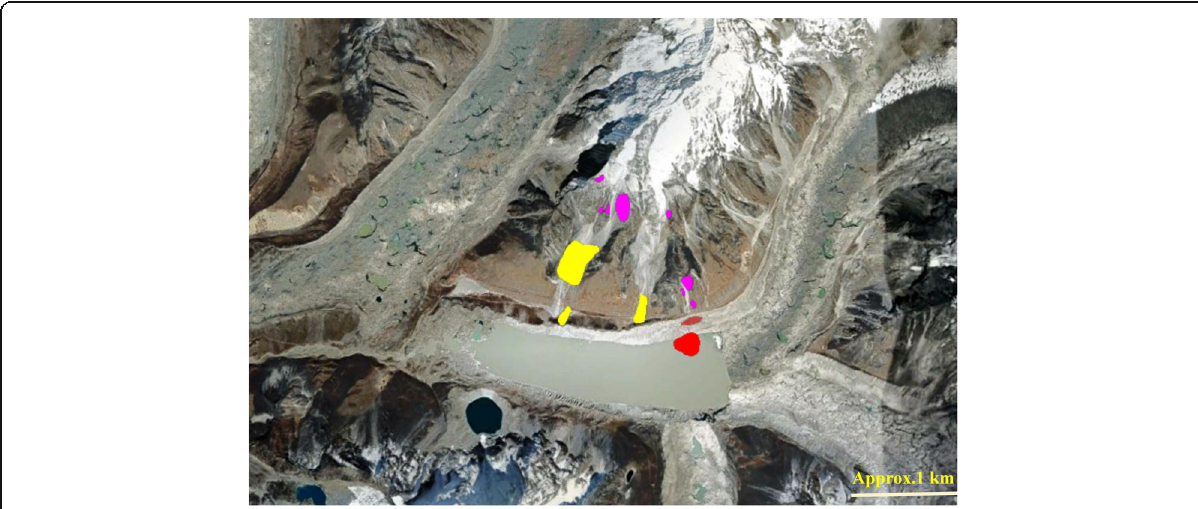
Fig. 15 Sources of rockfall and deposition area of rock blocks in the Imja Glacial Lake area. In Plot I and Plot II, the boulders cannot enter to the lake. But at Plot III area, boulders can enter into the lake (Image Source Google